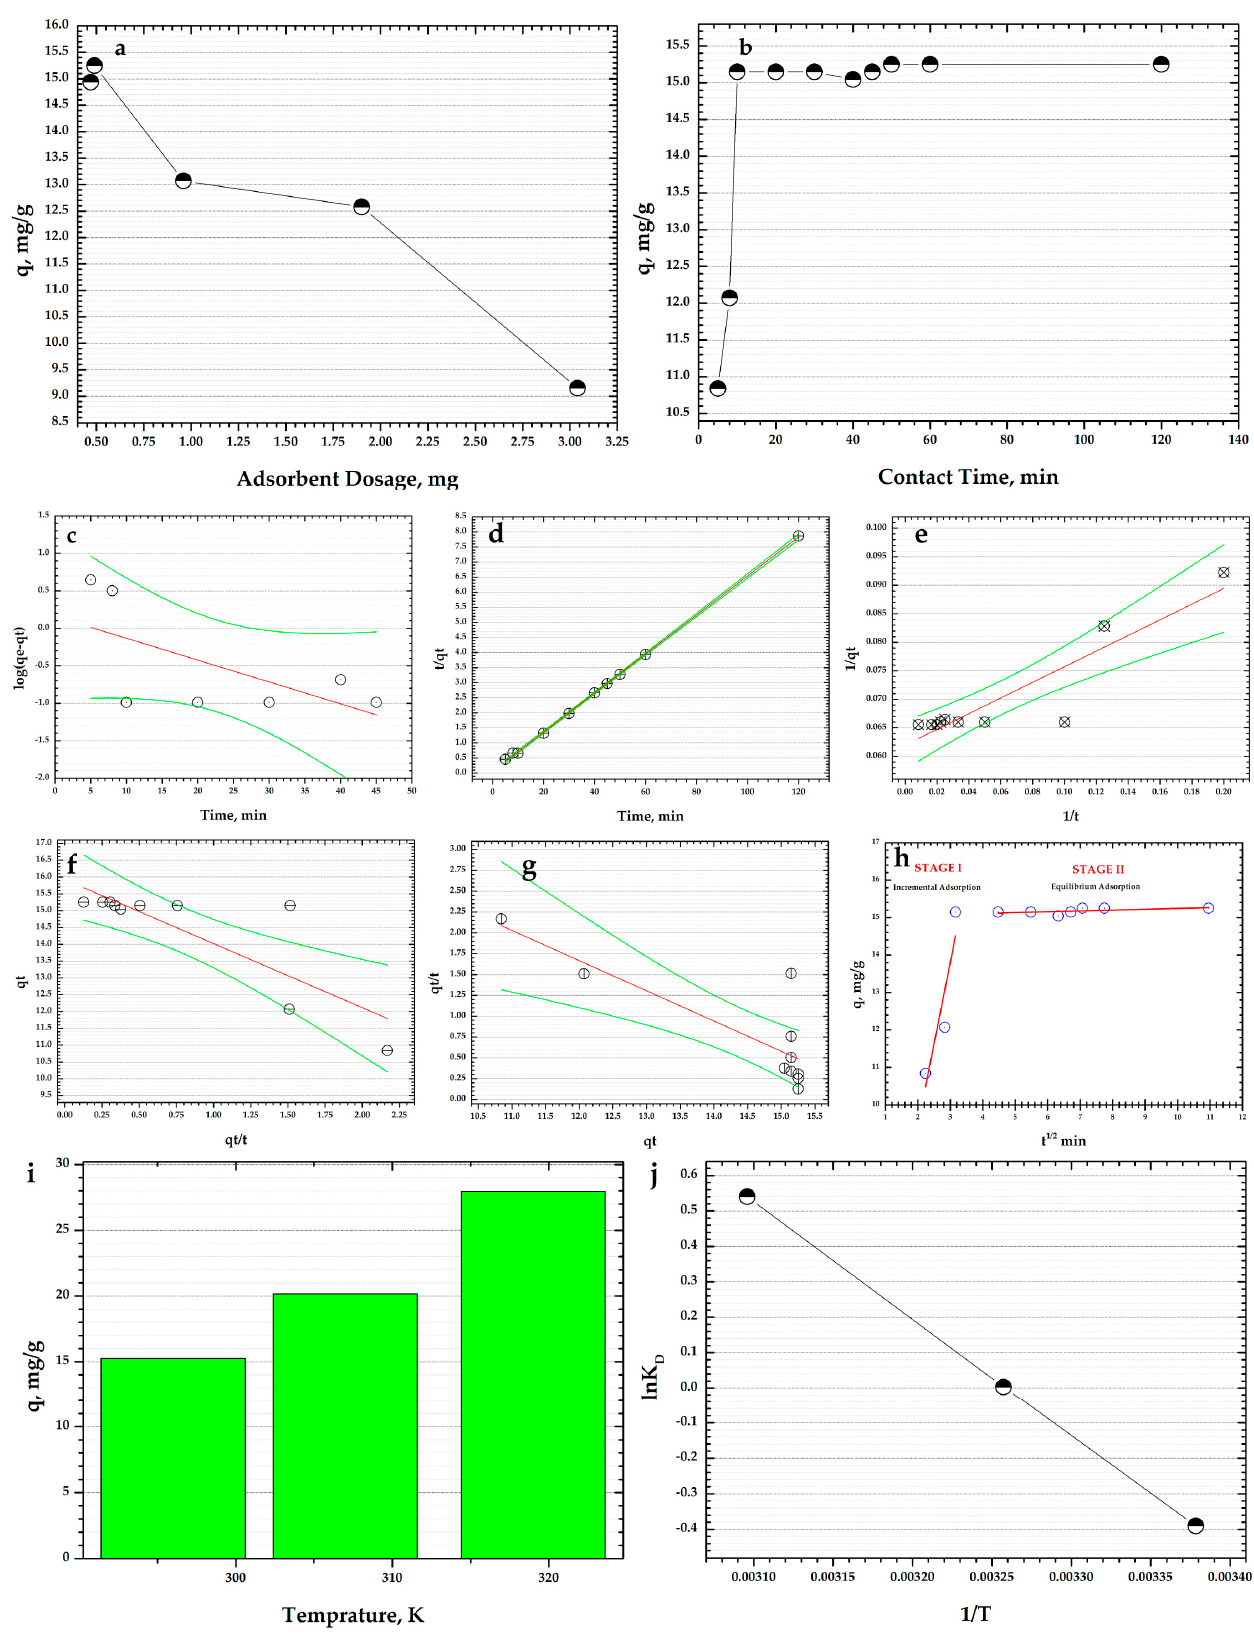
Figure 8. ( a ) Effect of CoFe 2 O 4 -HaP dosages on the dye adsorption (conditions: intermittent stirring at natural pH; room temperature, ~23 ◦ C; initial dye concentration: 30 mg/L; contact